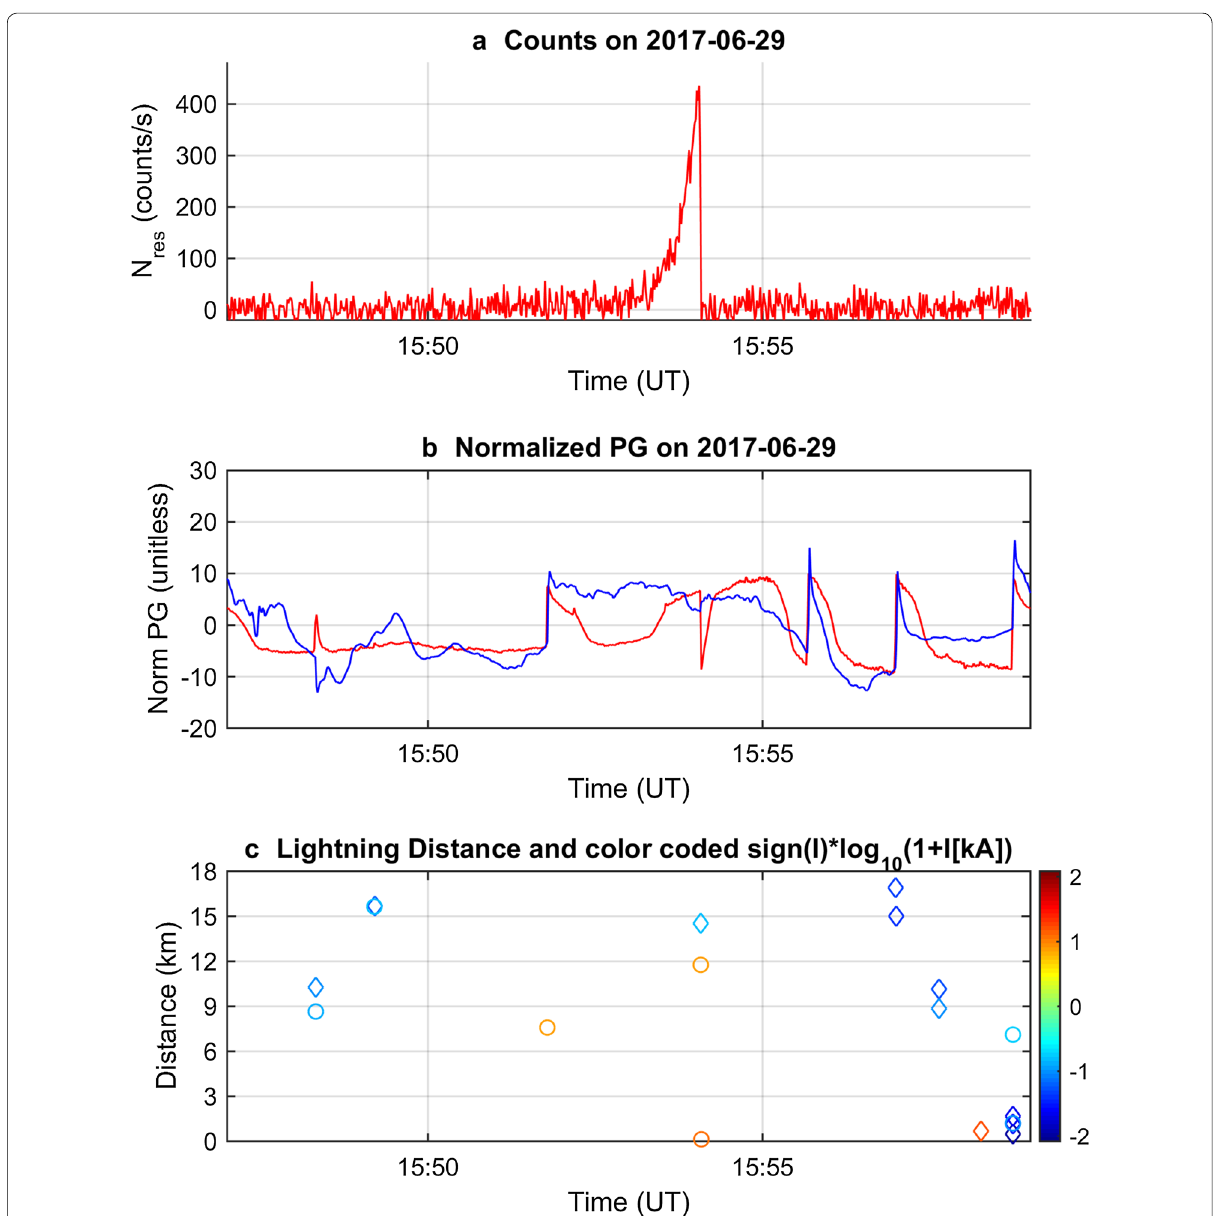
Fig. 5 Event recorded on 29 June 2017 around 15:53 UT. a Residual counts at Lomnicky peak by red. b Normalized PG at Lomnicky peak (red) and Skalnate Pleso (blue). c Lightning distances from Lomnicky peak as recorded by EUCLID lightning detection network; CG discharges are by diamonds, IC by circles, peak current I is color-coded; the color approximately corresponds to the common logarithm of the peak current in kA, sign of the current is